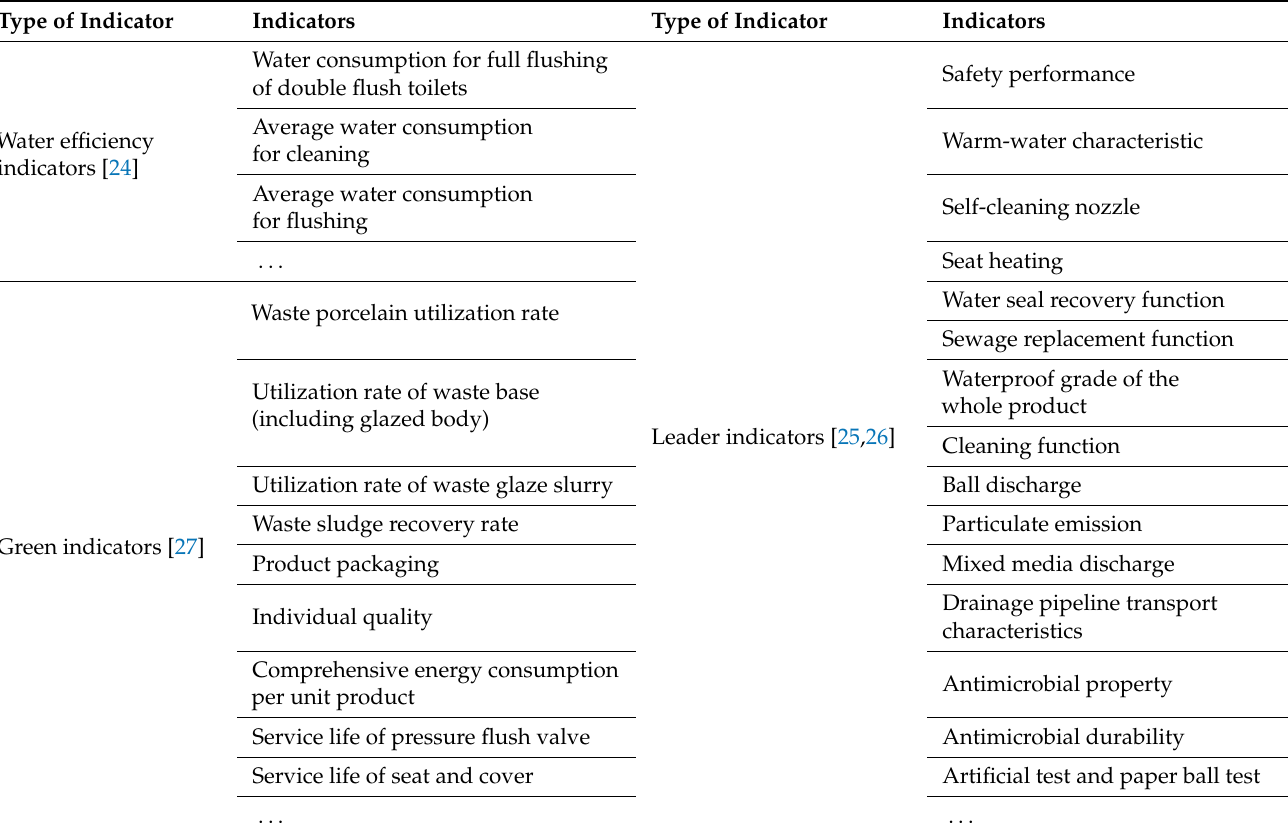
Table 2. Indicator database of smart water